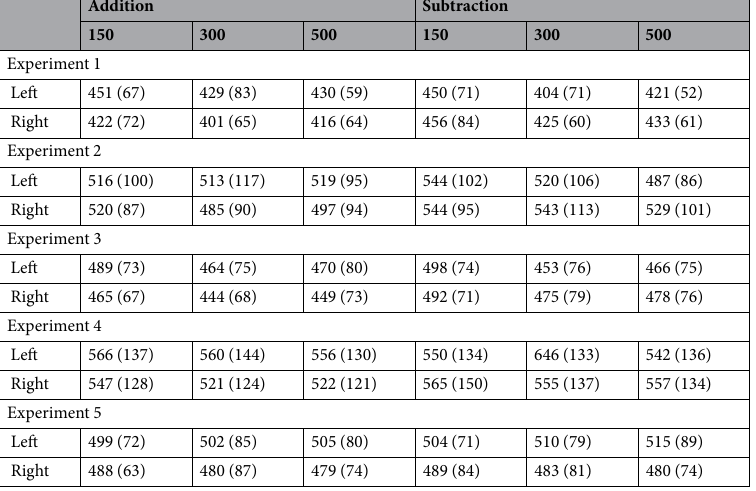
Table 1. Mean RT (and SD) of the target detection task as a function of Operation, Target side, and Delay (in ms) in five